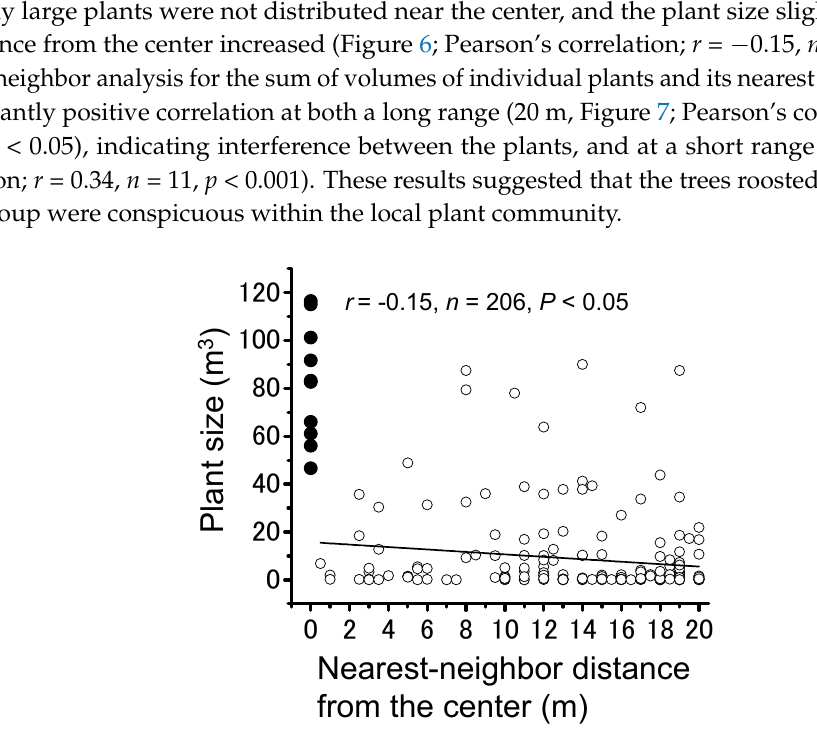
Figure 6. Relationship between distance from the center tree roosted on by the largest group of gregarious Schistocerca gregaria nymphs and individual plant size (m 3 ).